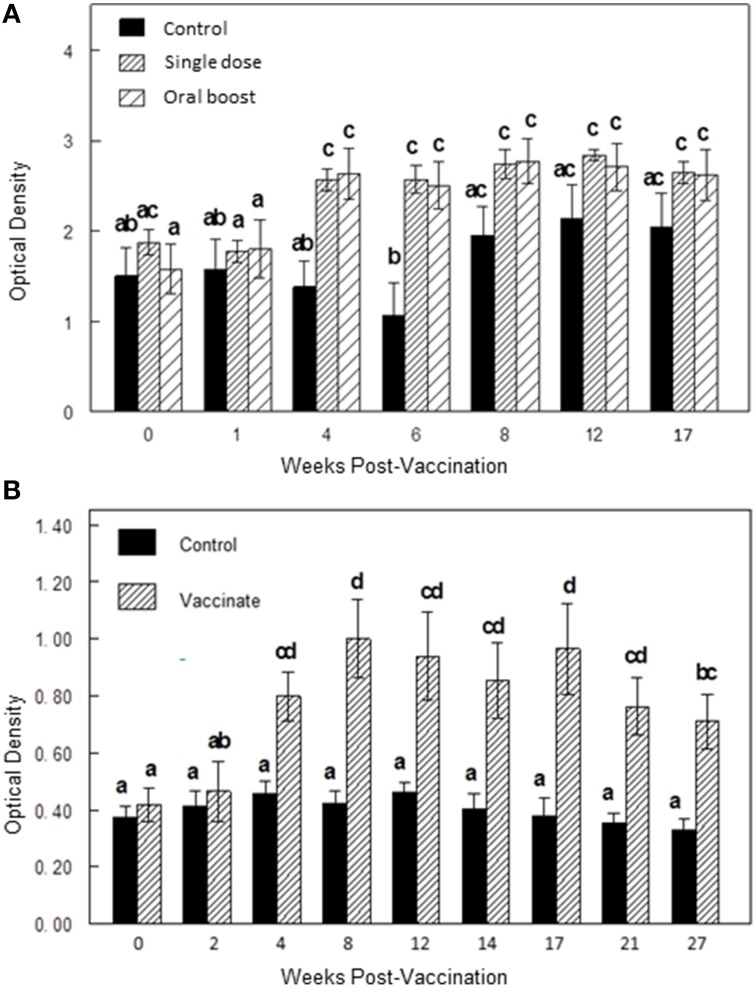
(A,B) Differences in antibody responses (ELISA; mean optical density ± SEM) to sRB51 between vaccination groups at multiple time points in Experiment 1 (A) and Experiment 2 (B). (A) In Experiment 1, mean responses to sRB51 were greater (P < 0.05) in the single dose group and the oral boost group at 4 and 6 wk after initial vaccination as compared to serologic responses of the control group. Elk in the single dose and oral boost groups were vaccinated with 2 × 1010 colony forming units sRB51+SODc, WboA intramuscularly (0 wk) and elk in the oral boost group were orally vaccinated with 1 × 1011 colony forming units sRB51+SODc, WboA at wk 6. The control group received phosphate buffered saline intramuscularly. (B) In Experiment 2, mean responses to the sRB51 were greater (P < 0.05) in the vaccinated group at 4, 8, 12, 14, 17, 21, and 27 wk after initial vaccination as compared to controls. Elk in the vaccinate group were orally vaccinated with 1 × 1011 colony forming units sRB51+SODc, WboA at wk 0. Elk were boosted with the same preparation at wk 40 although this figure does not reflect antibody responses post-booster. The control group received diluent orally. In both figures, bars with differing letters differ significantly from each other (p < 0.05).